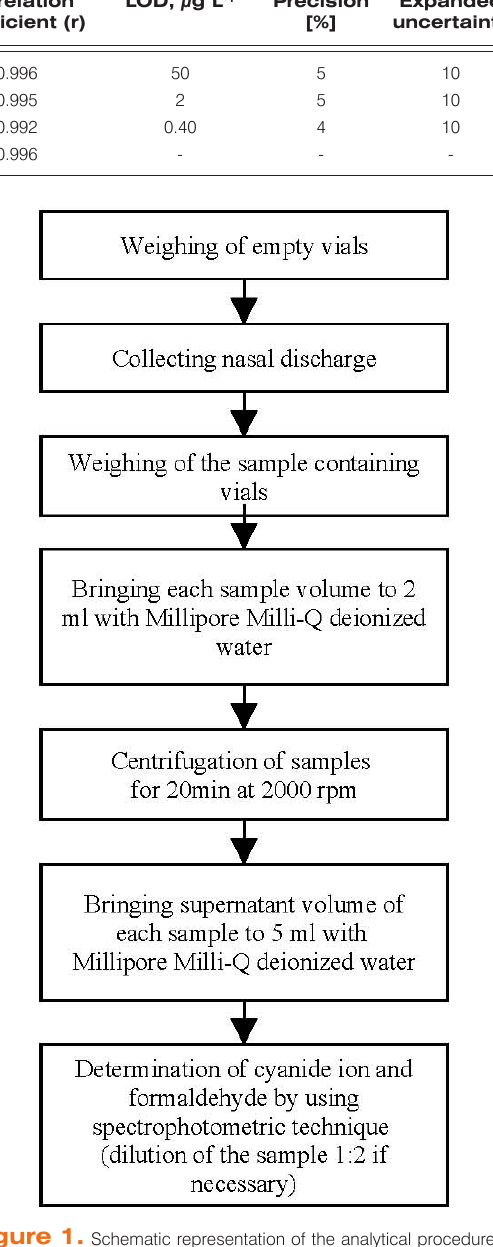
Figure 1. Schematic representation of the analytical procedure for determining cyanide ion and formaldehyde in the nasal discharge